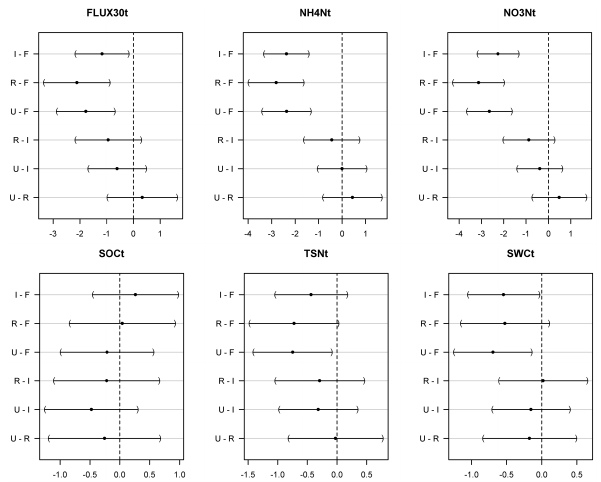
Figure 4. The Tukey’s honest significant difference analysis for FLUX30t, NH4Nt, NO3Nt, SOCt, TSNt and SWCt based on the four-chamber placement positions (R, inter-row; F, fertilization point; U, under tea tree; and I, in the tea tree